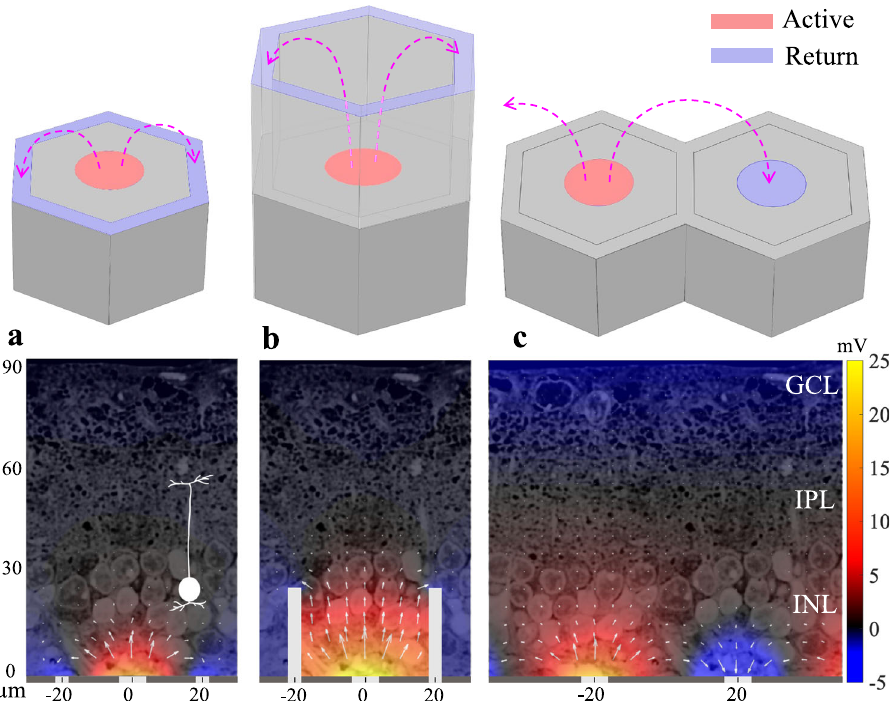
Fig. 2 | Electric fi eld with various implant geometries overlaid on retinal his- tology. Electric fi eld above the photovoltaic pixels (40 μ m in width) of various geometries, with a potential relative to the middle of IPL (57 μ m). a A bipolar pixel containingacentralactiveandacircumferentialreturnelectrode. b Ahoneycomb- shapedpixelwithelevatedreturnelectrode 12 . c Twomonopolarpixelswithoutlocal returns,wheretheactiveelectrodeoftheleftpixelactsasananodeandtheoneon theright — asacathode,collecting75%oftheanodalcurrent.Theremainingcurrent